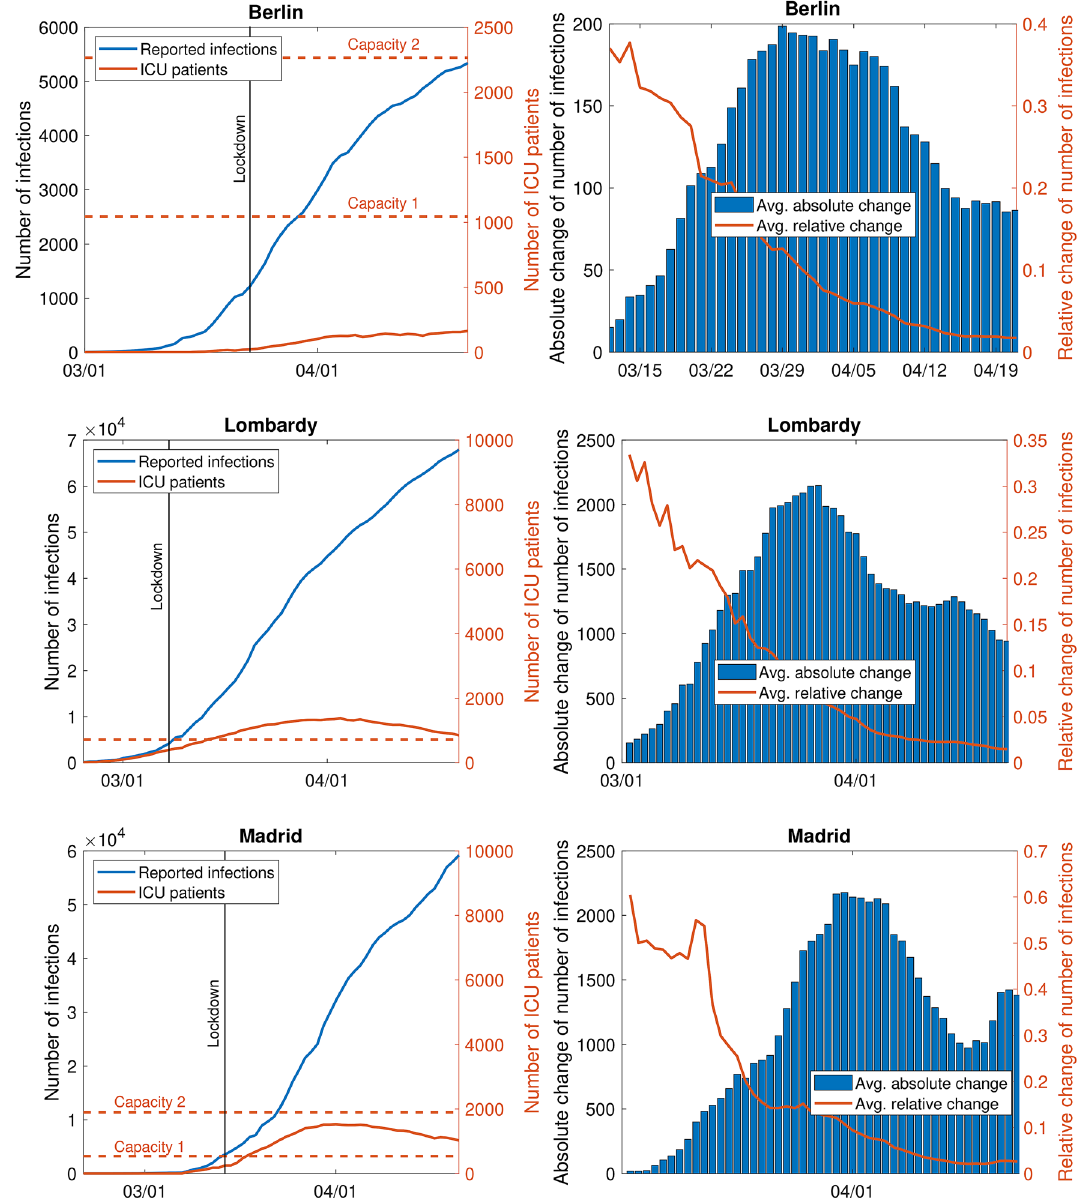
Figure 1. Number of reported infections and intensive care patients (left) and absolute and relative daily change of the number of infections (right, averaged over the last 7 days, since 100 infections) in Berlin, Lombardy, and Madrid; based on data from the Berlin Senate Department of Health, Nursing and Equal Opportunities (Berlin), the Presidenza del Consiglio dei Ministri—Dipartimento della Protezione Civile (Lombardy), and Datadista